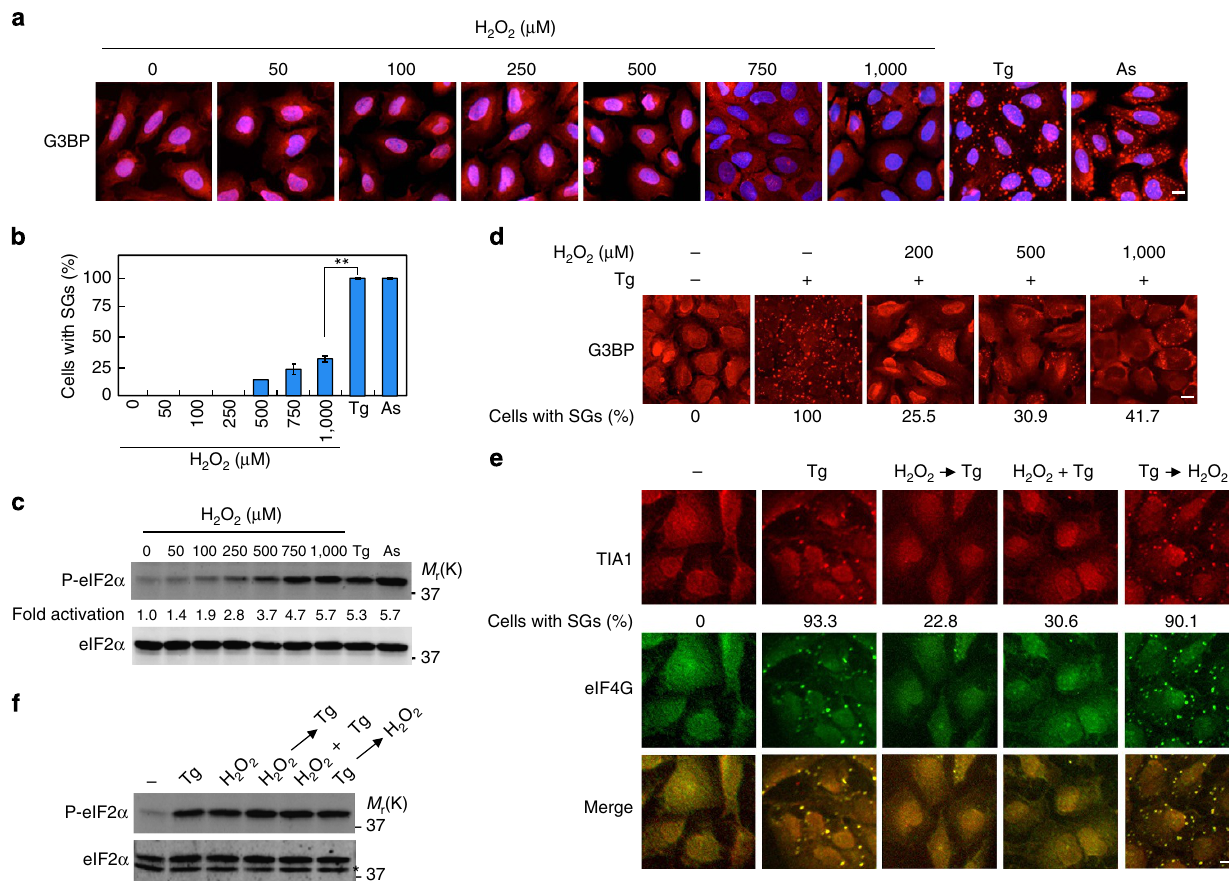
Figure 1 | H 2 O 2 inhibits SG formation. ( a – c ) U2OS cells were treated with the indicated concentration of H 2 O 2 , 1 m M thapsigargin (Tg) or 0.5mM arsenite (As) for 50min, and SGs were visualized by G3BP immunofluorescence ( a ) and the percentage of cells containing SGs was determined ( b ). Error bars indicate s.e.m. ( n ¼ 3). ** P o 0.01, Student’s t -test. In c , phosphorylated eIF2 a was probed with phospho-eIF2 a antibody (upper row). eIF2 a protein expression level is shown (lower row). ( d ) U2OS cells were treated with 1 m M Tg together with the indicated concentration of H 2 O 2 for 50min. TIA1 and eIF4G were visualized by immunofluorescence and the percentage of cells containing SGs was determined. ( e , f ) U2OS cells were treated with 1 m M Tg either alone, 20min after 200 m M H 2 O 2 or simultaneously with H 2 O 2 , or were treated with H 2 O 2 20min after Tg. Fifty minutes after Tg treatment SGs were visualized with two SG markers, G3BP (red) and eIF4E (green) ( e ). Phosphorylation level of eIF2 a was assessed by immunoblotting using